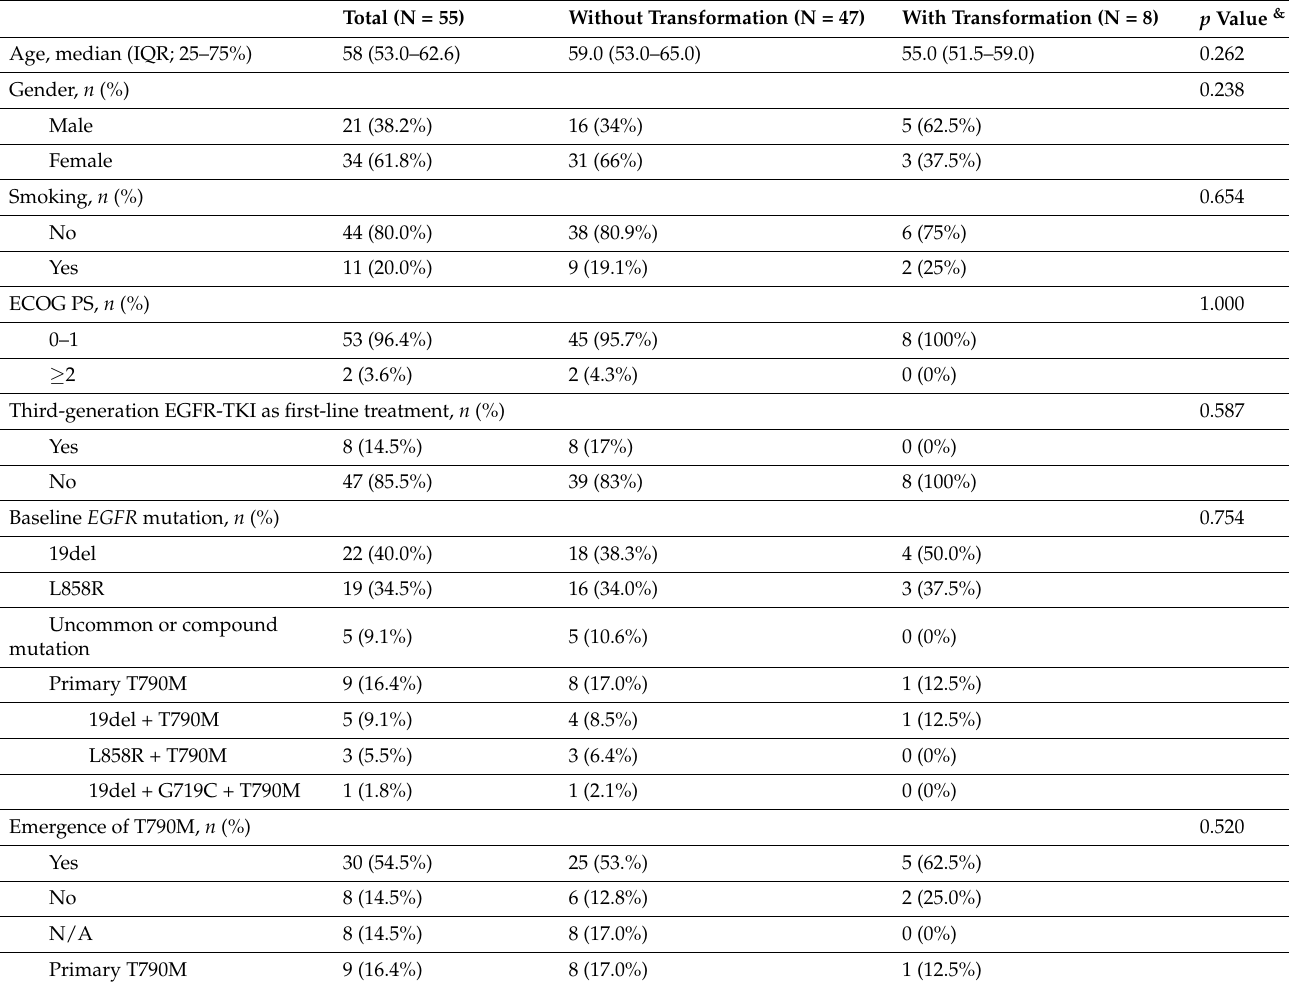
Table 1. Characteristics of patients with or without histological transformation after the third- generation EGFR-TKI